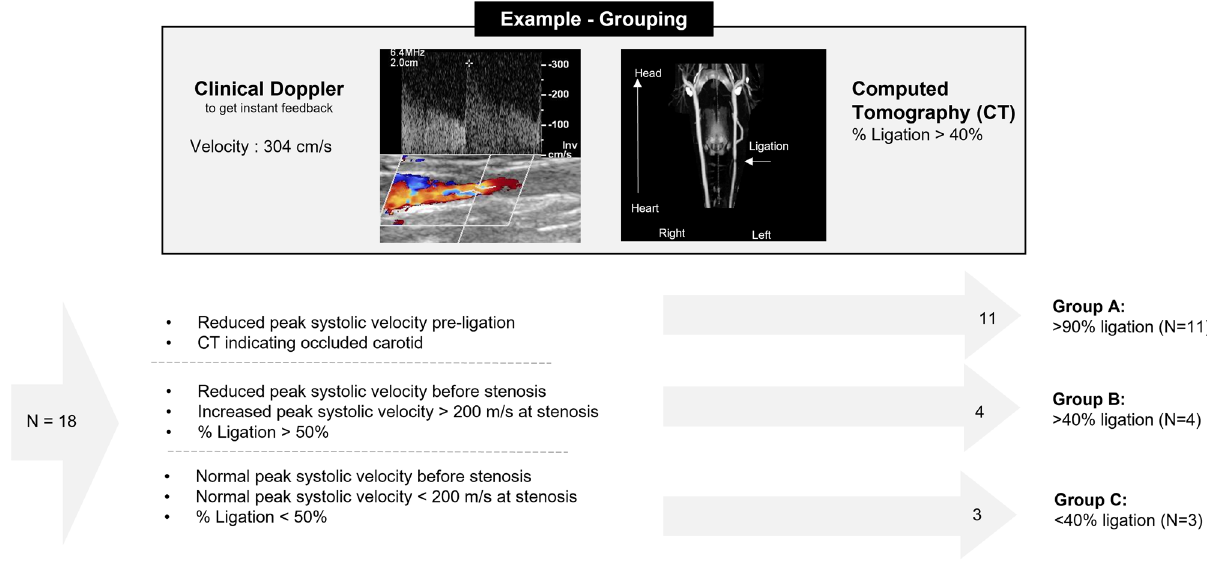
Figure 8. Qualitative example of grouping. The carotids in which no ligation was noticeable on computed tomography (CT) and/or clinical ultrasound were grouped into group A. When a narrowing was noticeable on computed tomography (and/or increased peak systolic velocity was measured at the ligation it was categorized as B. When almost complete ligation as observed on computed tomography and/or ultrasound it was categorized as group